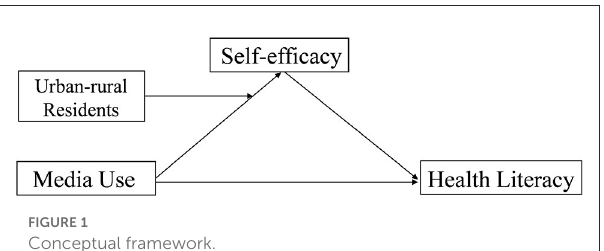
FIGURE1 Conceptual